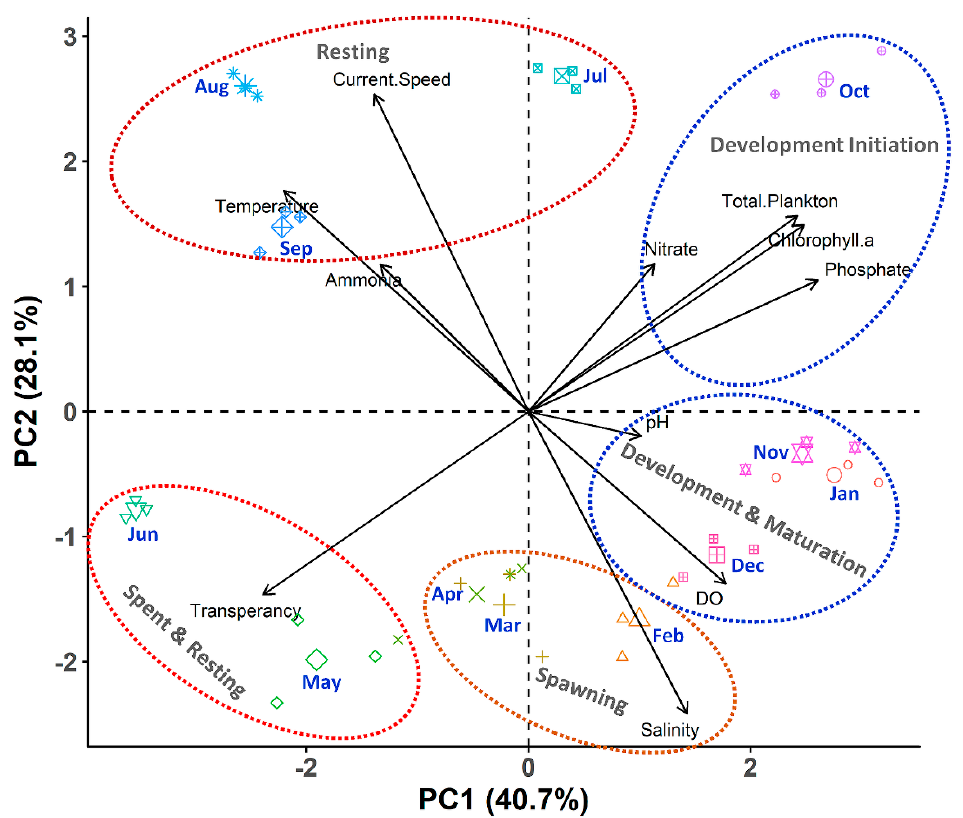
Figure 6. Biplot of principal component analysis (PCA) of the monthly variation of different water quality parameters of the Moheshkhali channel of Bangladesh (green mussel collected sites) for the period of November 2017 to October 2018. The analysis is based on the three replicated measurements of water quality parameters for each month (n = 36).